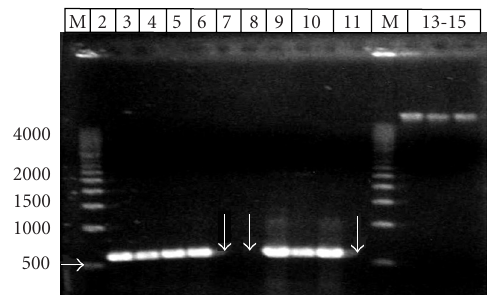
Figure 5. PCR analysis of transformed Pichia pastoris cells showing inserted pleurocidin cDNA at 590bp. M represents 500 bp marker. Lanes 2–5 represent transformed DNA ( P pas- toris KM71H and X-33). Lanes 6–7 represent control DNA (un- transformed cells in lanes) indicated by parrallel arrows. Lanes 8–9 represent vector DNA (vector with and without insert). Lane 10 represents vector with transformed DNA. Lane 11 represents PCR control (no DNA) indicated by single arrow. Lanes 13–15 represent yeast